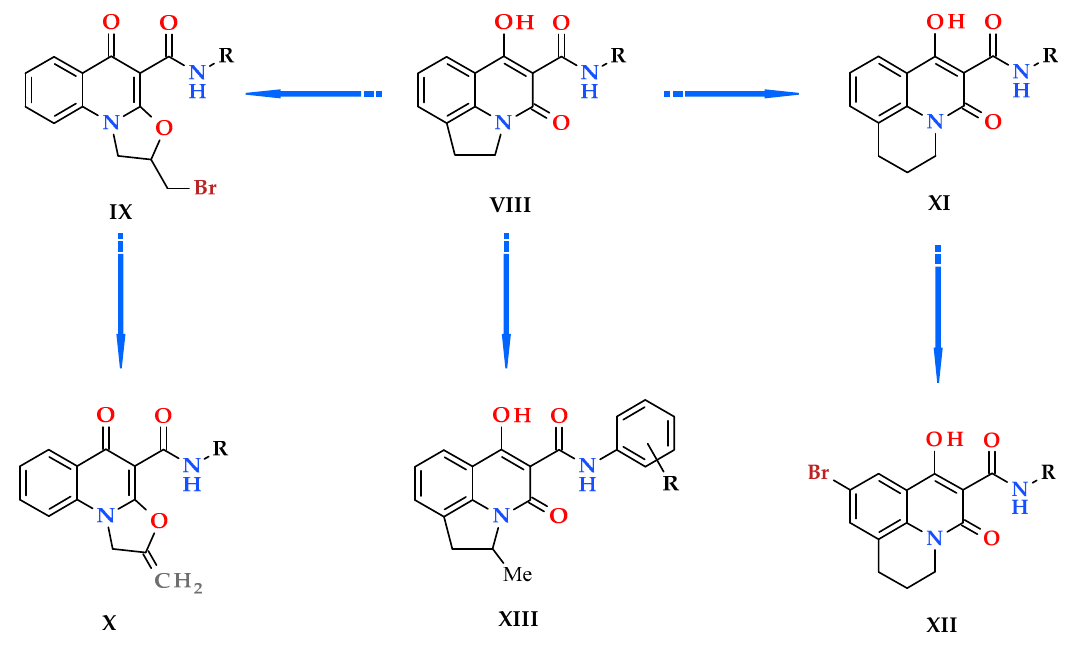
Figure 3. Tricyclic “me-too” clones of 4-hydroxyquinoline-2-one diuretics [14,22–28].